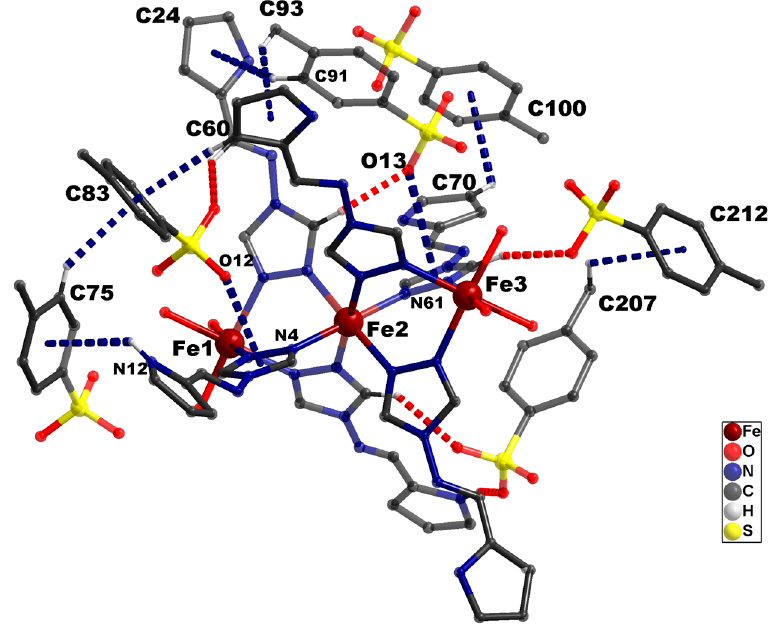
Figure 6. The different intramolecular interaction found in the trimer units. The red dashed lines represent H-bonding, while the blue dashed lines represent π – π stacking.